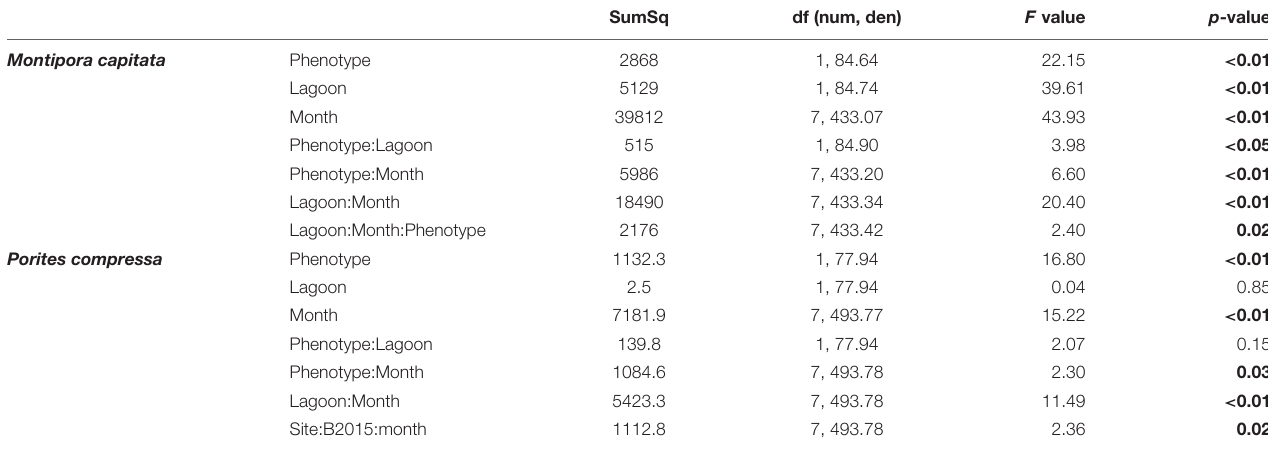
TABLE 3 | Type II Analysis of Variance Table with Satterthwaite approximation for the effects of bleaching phenotype, lagoon, and recovery time across the course of the study, on partial mortality of bleaching susceptible and resistant colonies for Montipora capitata and Porites compressa at Inner and Outer lagoons (Partial Mortality ∼ Phenotype × Lagoon × Month + (1|Coral Tag